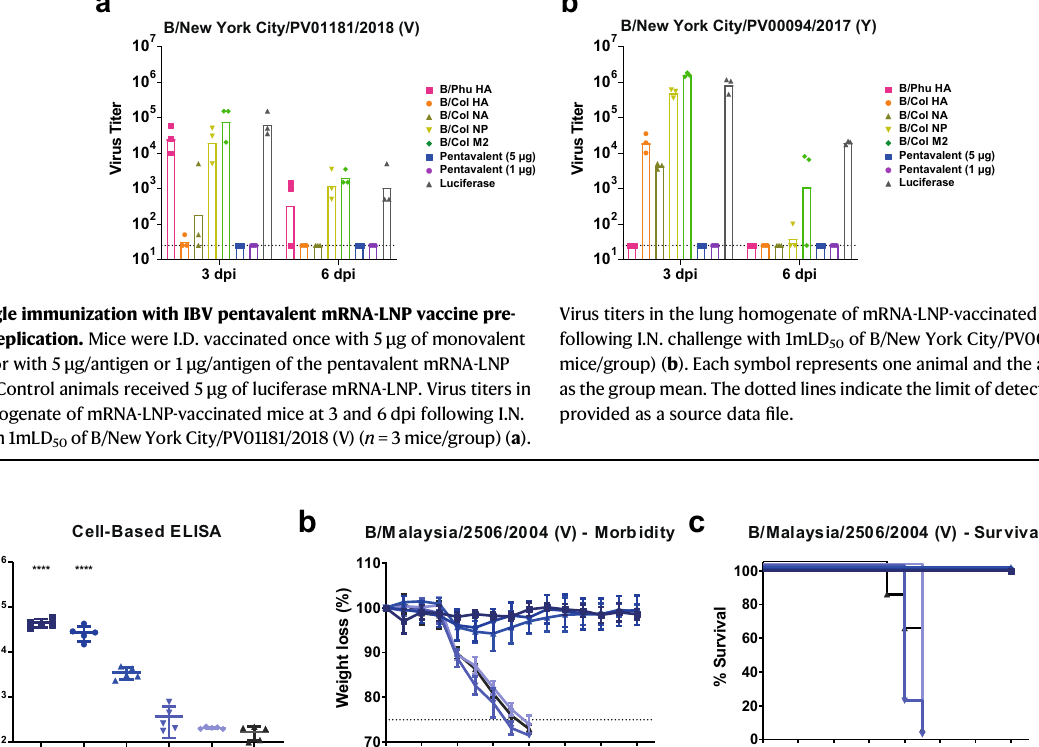
5mLD 50 of B/Malaysia/2506/04 (V) in fl uenza virus and morbidity ( b ) and sur- vival( c )weremonitoredfor14dpi. Dataareshownasindividual datapoints and the group average presented as the group mean ( n =5 per group). Signi fi cance was assessed using a one-way ANOVA and groups were compared to the luci- ferase control group at each time point. The dotted line in b indicates the maximum body weight loss (25%) for the experiment. Source data are provided as a source data fi